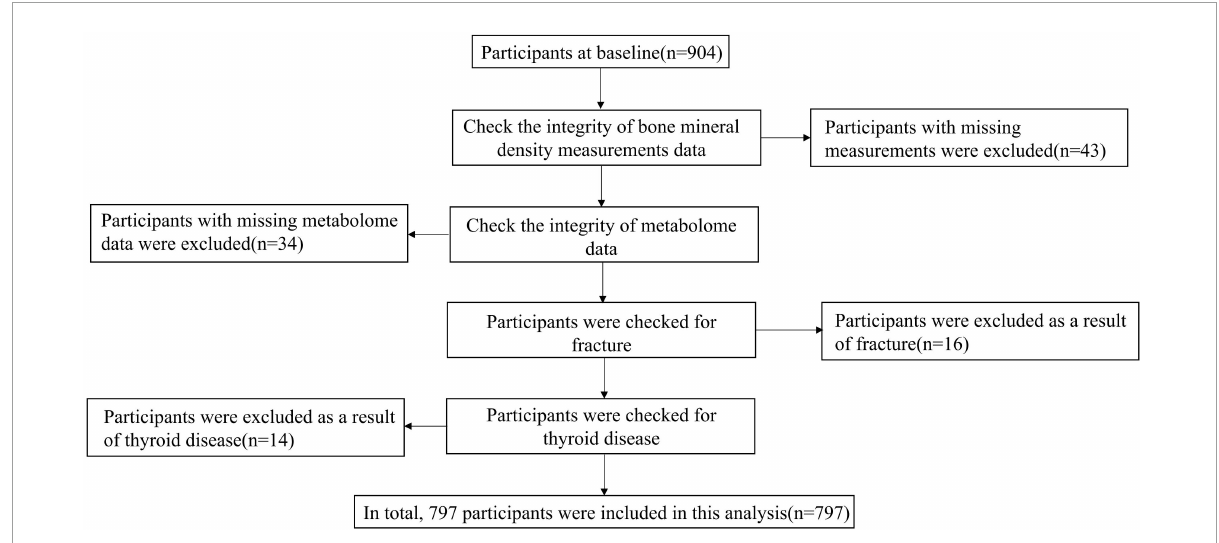
FIGURE1 Flowchart of the study